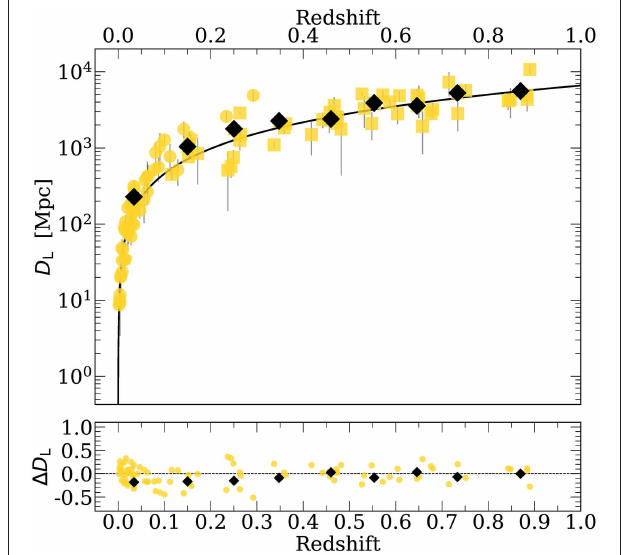
FIGURE 6 | Hubble diagram after the correction by dimensionless accretion rate. Markers and colors are the same as in Figure 1 . The black lines indicates the expected luminosity distance based on the standard 3 CDM model. The black diamonds represent the average values for the D L considering redshift bins of 1 z 0.1. The bottom panel shows the difference between the = expected luminosity distance and the observed